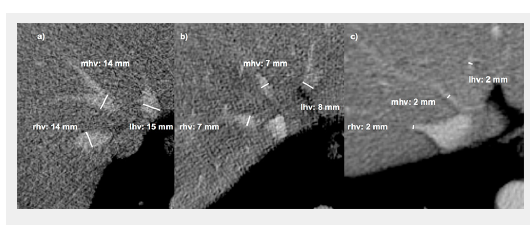
Caudate right-lobe ratio (crl-r) in a patient with liver fibrosis. In axial planes distances of the right lateral border of the right portal vein bifurcation to the lateral margin of the right hepatic lobe (a) and to the most medial margin of the caudate lobe (b) are measured in an exactly horizontal direction. The two distances were divided b / a (caudate lobe / right lobe) and defined as the caudate-right-lobe ratio